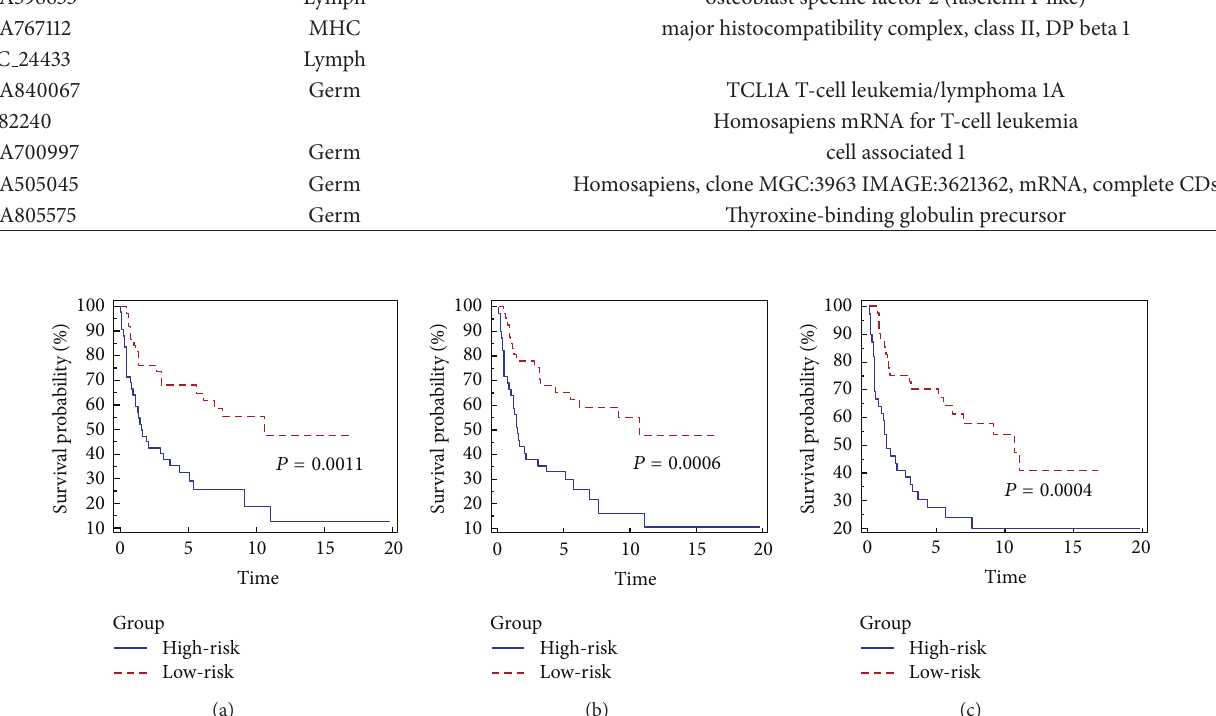
Figure 1: The Kaplan-Meier curves for the high- and low-risk groups defined by the estimated scores for the 80 patients in the test dataset. The scores are estimated based on the models estimated by the Lasso method (plot (a)), the adaptive Lasso method (plot (b)), and the L 1/2 regularization shooting method (plot (c)). The maximal follow-up time is 20 years.